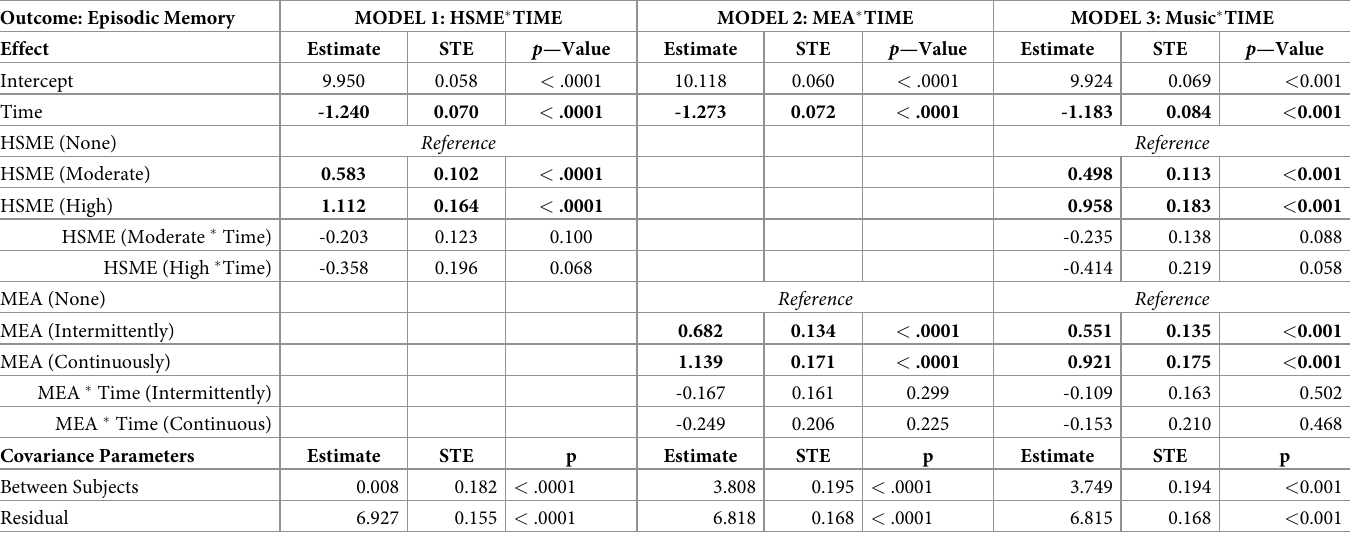
Table 2. Adolescent and adult musical engagement and memory